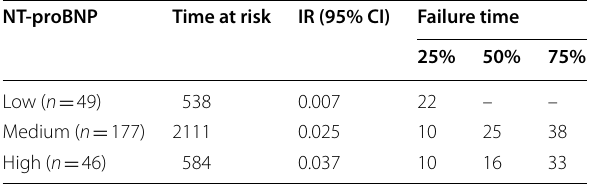
IR incidence rate